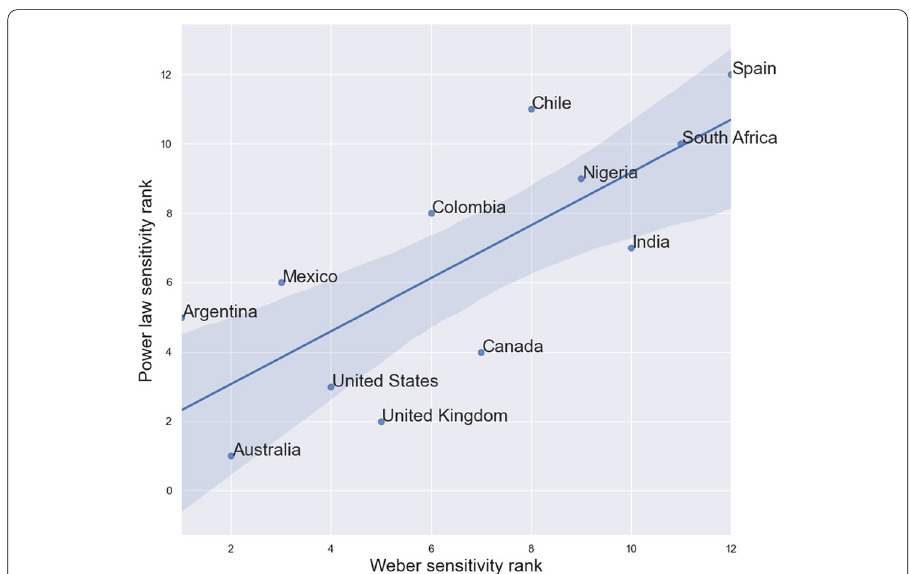
Fig. 7 Comparison of the rank of each country as determined by their k and β parameters in the Weber– Fechner and power-law fits, respectively, which determine the sensitivity of Twitter users tweeting from each country to changes in the number of daily reported deaths. Low rank indicates high sensitivity relative to the remaining countries. The correlation between countries’ ranks from both measures is high at